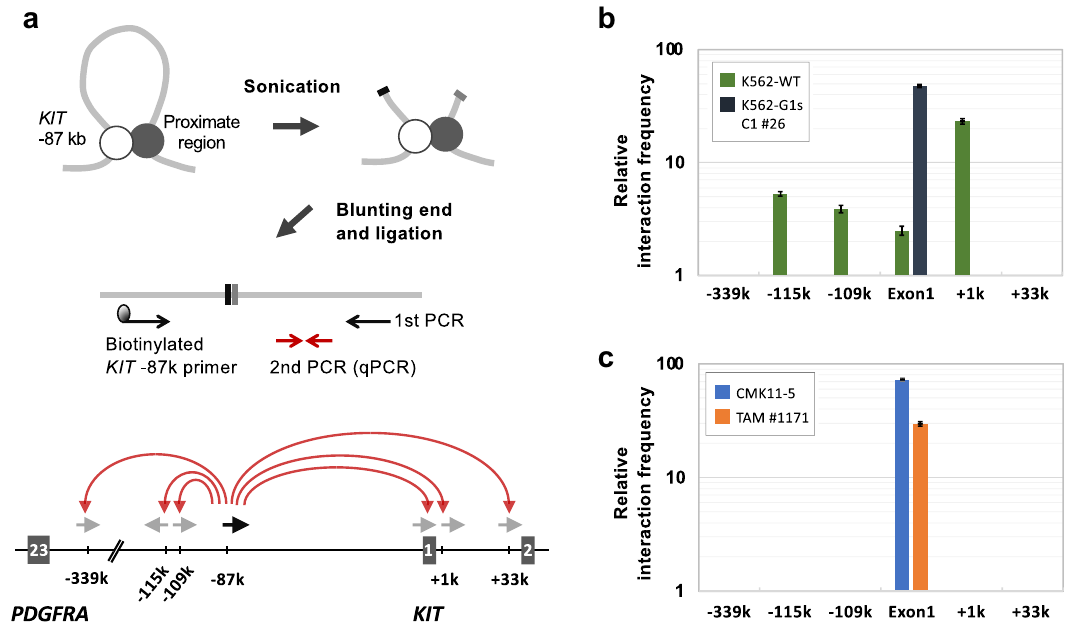
Figure 5. KIT gene conformation involving the KIT − 87 kb region. ( a ) Outline of the 3C-modified experiment. Upper left panel is an image of the KIT − 87 kb region and a conformationally proximate region. The white and black circles indicate transcription factor complexes containing GATA factors. Sonicated DNA–protein complexes (upper right) were end-blunted and ligated. Middle panel is a schematic diagram of PCR for detecting proximity with KIT − 87 kb region using the ligated DNA. Lower panel shows the positions of the primers used for the 1st PCR of this assay. The black arrow indicates the biotinylated KIT − 87 k primer and the gray arrows indicate the position of the test primers. The − 339 kb region is located 21 kb downstream of the PDGFRA gene, which is upstream of KIT gene. The + 33 kb region is located at intron1 of KIT gene. Both the − 339 kb and + 33 kb regions are used as the negative control regions. ( b ) Sonication-based 3C-assay of the KIT − 87 kb region with K562-WT and K562-G1s C1 #26. The horizontal axis represents the regions where the interaction was investigated. The vertical axis shows the relative value when the amplification amount of qPCR per 1 ng of each input DNA is set to 1. When the value was 1 or less, it was conceived that there was no effect of amplification by the first PCR, that is, the intended ligation product was not present, and the values were cut off. A representative data is shown. Error bars represent standard deviation. ( c ) Sonication-based 3C assay of KIT − 87 kb region with CMK11-5 and a TAM